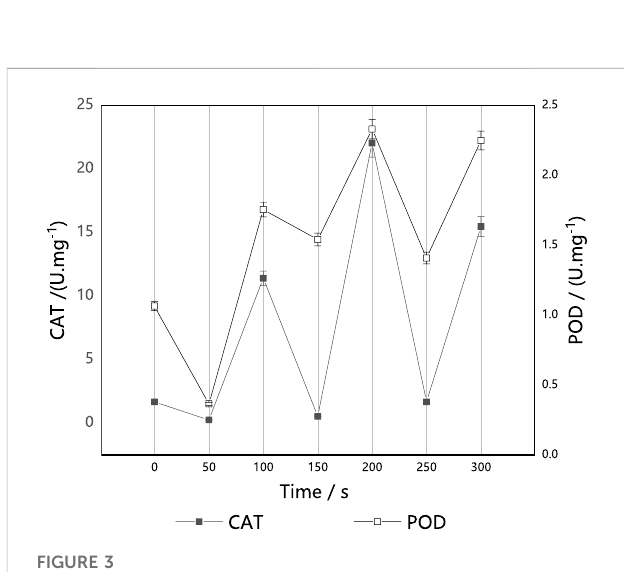
FIGURE 3 Effect of ARTP implantation time on CAT and POD activities of M. thermophila . CAT activity was determined by ammonium molybdate colorimetry. Reagents preparation and results determination were carried out according to kit requirements. All experiments were carried out four times (biological duplicates and technical duplicates) and mean values presented with standard